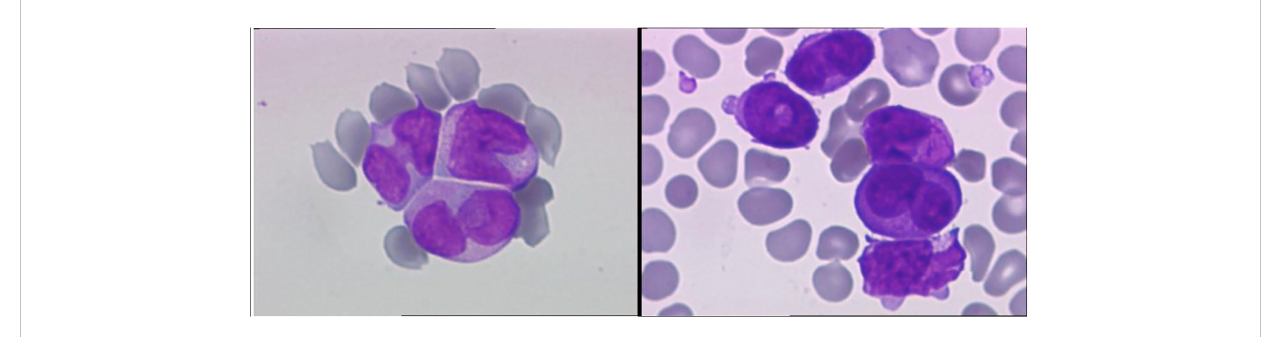
FIGURE 1 A typical promyelocytes with rare Auer rods, bilobed and reinform nucleus (MCG,